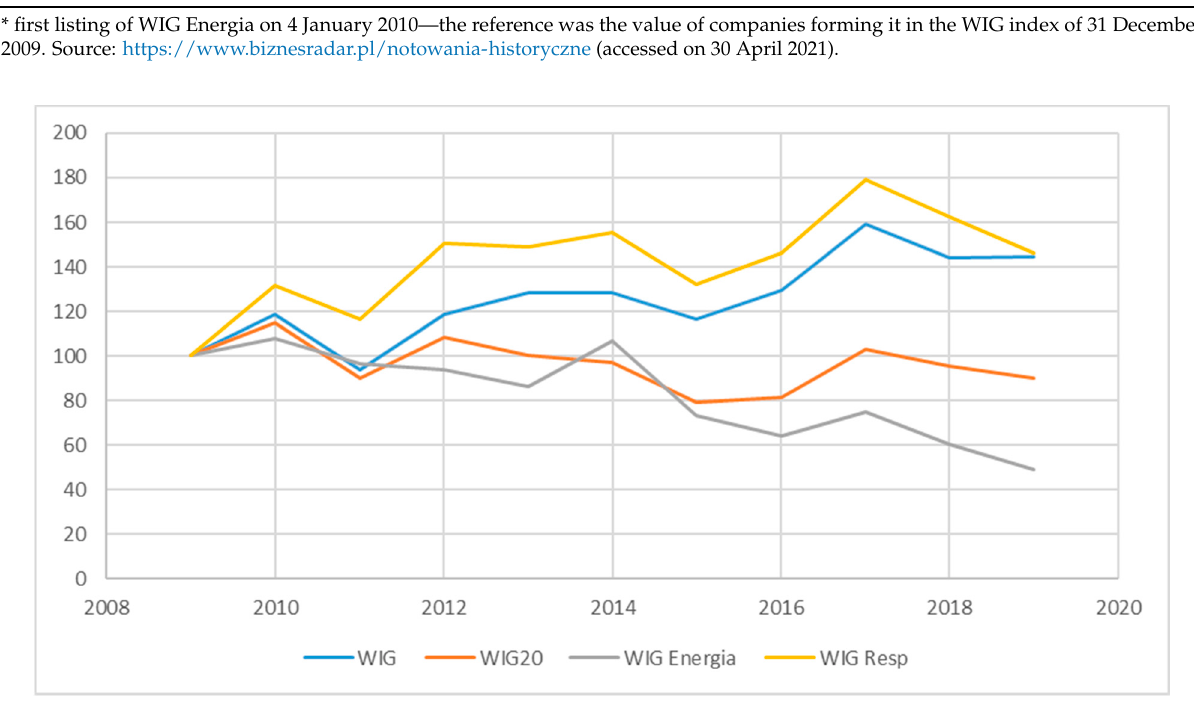
Figure 1. Changes in the values of the WIG, WIG 20, WIR RESPECT, and WIG Energia indices in the years 2009–2019 (2009 = 100). Source: Own elaboration.